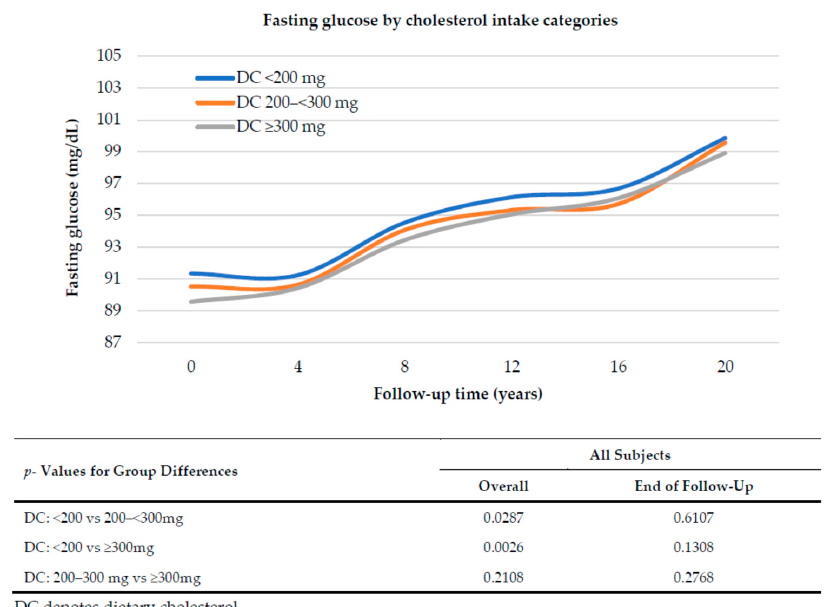
Figure 1. Fasting glucose over 20 years of follow up associated with dietary cholesterol intake category. Mean glucose levels are adjusted for sex, age, pack-years of smoking, BMI, percent of energy from carbohydrates, whole grains and dairy intake, using mixed linear regression models.